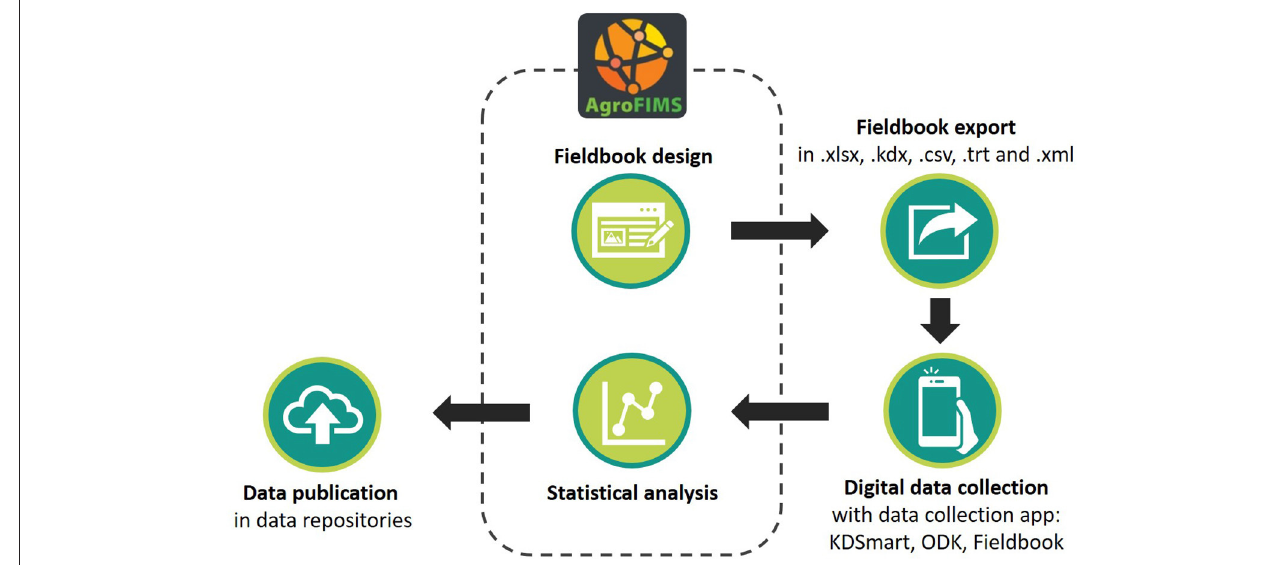
FIGURE 1 | Steps to design a fieldbook and manage agronomic dataset using AgroFIMS.